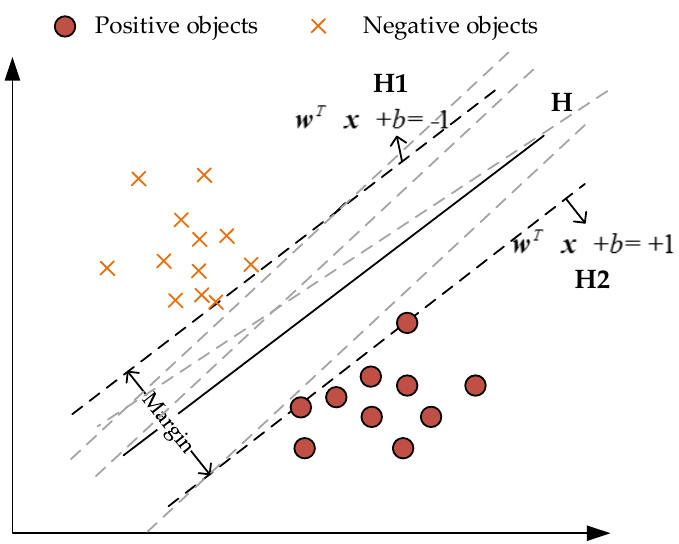
Figure 3. The optimal hyperplane.